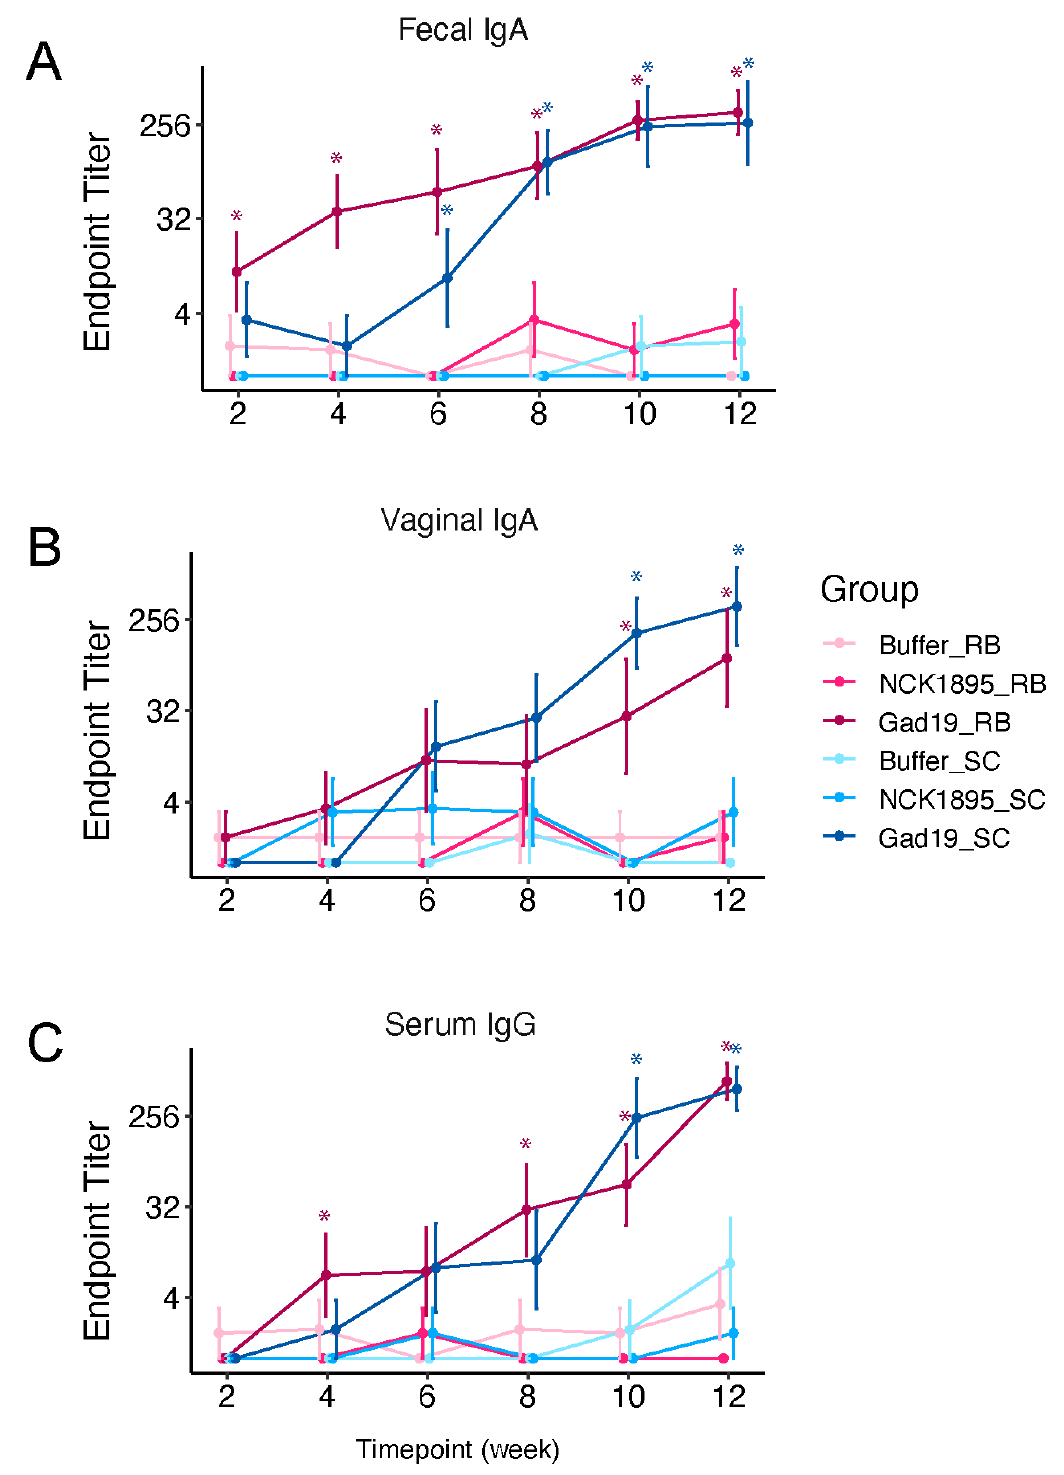
Figure 2. Diet improved antigen-specific antibody response to vaccination. Mice were fed either standard chow (SC) or SC supplemented with 10% rice bran (RB) throughout the study, and samples were taken every 2 weeks prior to the next vaccine boost. MPER-specific antibodies were detected with colorimetric ELISAs. ( A ) Fecal IgA, ( B ) vaginal IgA, and ( C ) serum IgG endpoint titers are reported for each group, with samples having no detection being assigned a value of 1. For all graphs, asterisks (*) indicate significance ( p < 0.05) compared to the Buffer groups. Adjusted significant p -values are listed in Supplementary Materials Table S1 for all comparisons.